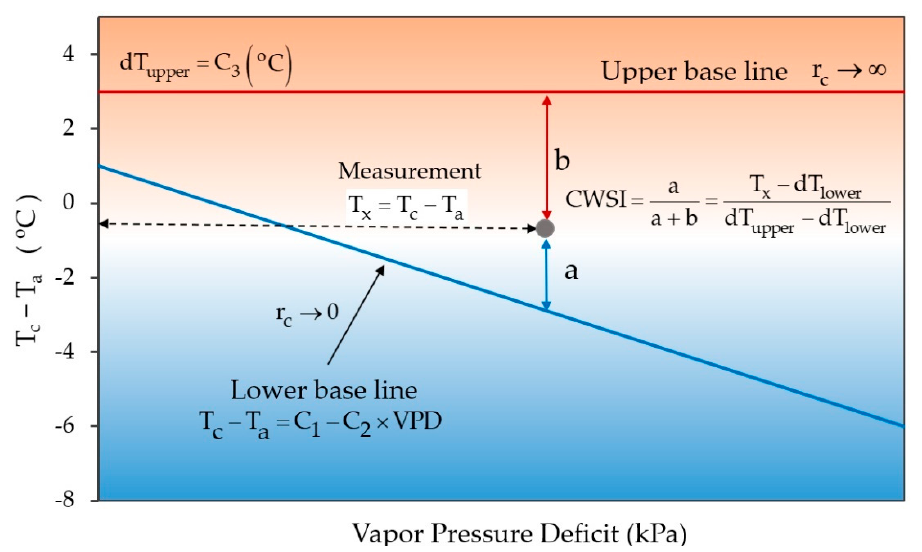
Figure 1. A schematic representation of the CWSI, which equals the relative distance of the measurement between the lower and the upper baselines.